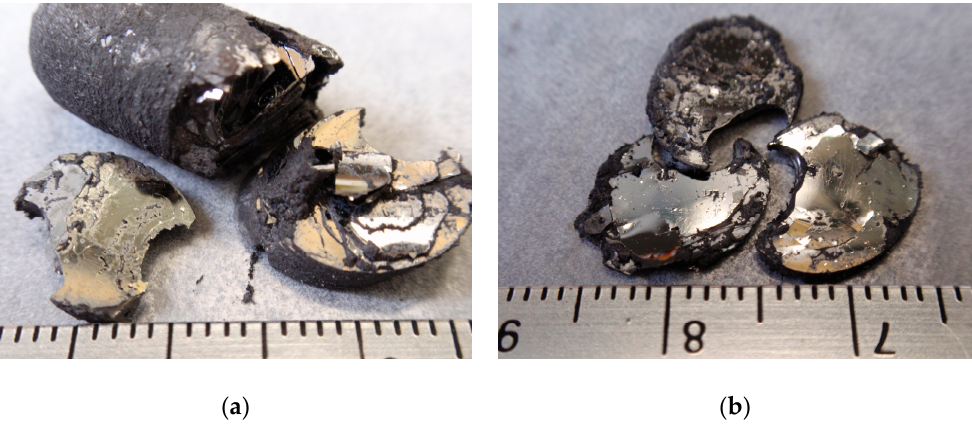
Figure 4 . ( a ) Photos of (Ba 1 − x K x )Fe 2 As 2 single crystals grown by a self-flux method. ( b ) The disk-like crystals (~1 mm in thickness and 10 mm in diameter) are formed in the top of the ingot.